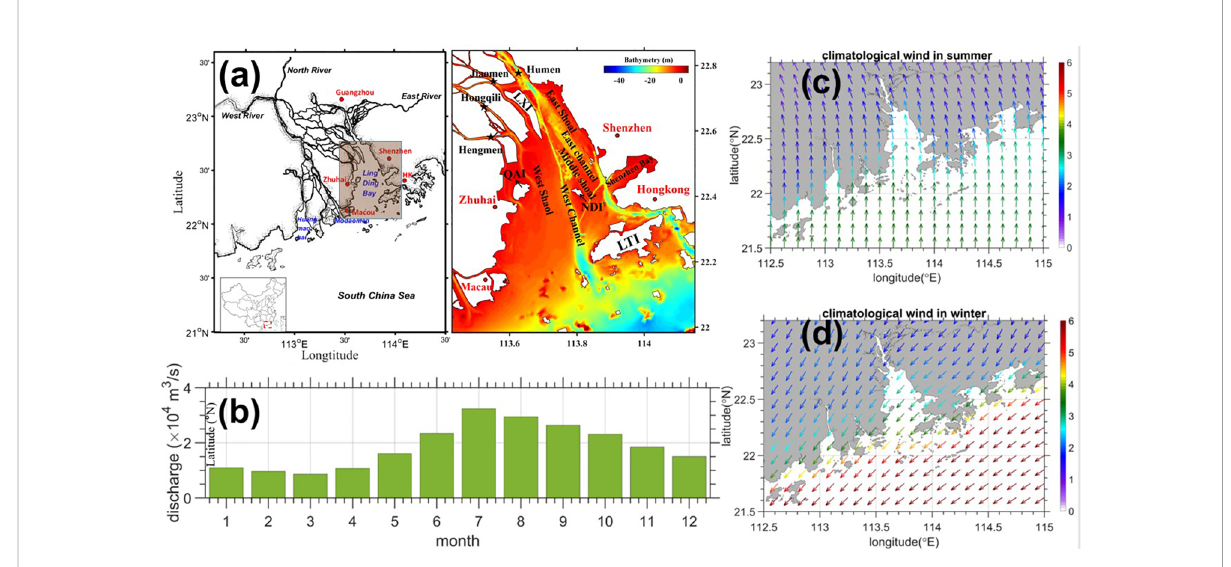
FIGURE 1 (A) Location and topography of the Pearl River Estuary (PRE). QAI: Qi ’ ao Island, NLI: Neilingding Island, LTI: Lantou Island, LXI: Longxue Island. (B) The monthly PRE river discharge (10 4 m 3 /s). (C, D) The seasonal mean wind speed (m/s) during summer (June – August) and winter (December – February). Atmospheric forcing data were provided by the ERA5 atmospheric reanalysis data from the European Center for Medium-Range Weather Forecasts (ECMWF), and the monthly averaged riverine discharge data were provided by Chu et al.